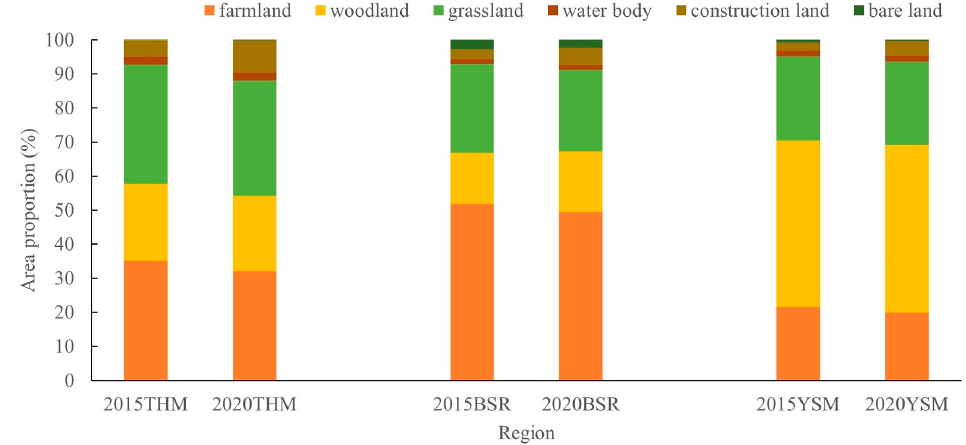
Figure 12. Area proportion of LULC in THM, BSR and YSM in 2015 and 2020 (THM—Taihang Mountain, BSR—Bashang region, YSM—Yanshan Mountain).